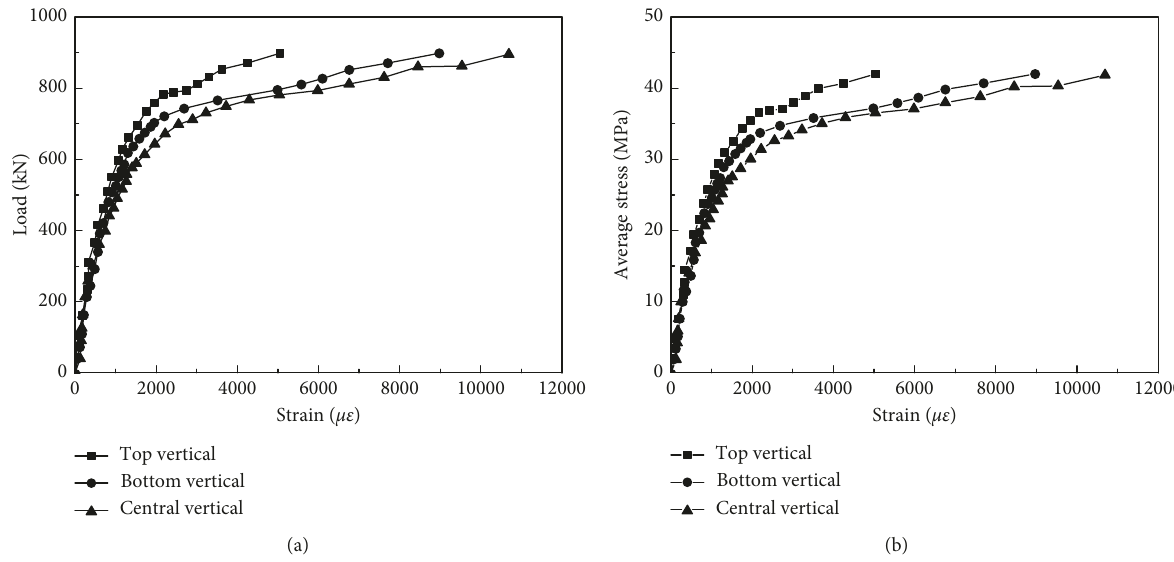
Figure 11: Vertical strain development laws of specimen RS-A-2 with steel casing. (a) Relationship of vertical strain development with load. (b) Relationship of vertical strain development with average stress.